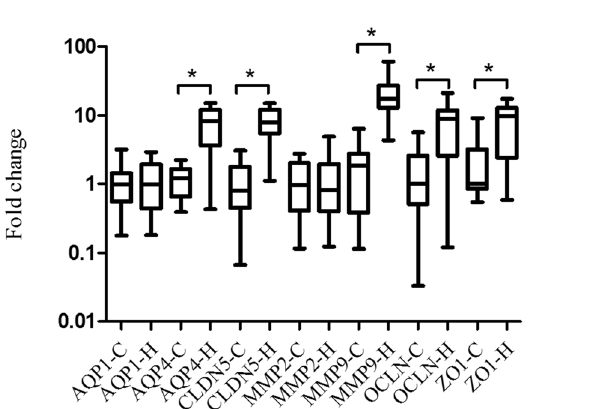
Figure 3. AQP1 , AQP4 , CLDN5 , OCLN , ZO1 , MMP2 and MMP9 mRNA expression levels after normalization against four validated reference genes. CNRQ values of AQP4 , CLDN5 , OCLN , ZO1 and MMP9 were significantly higher in the heat stroke group as compared to the control group.